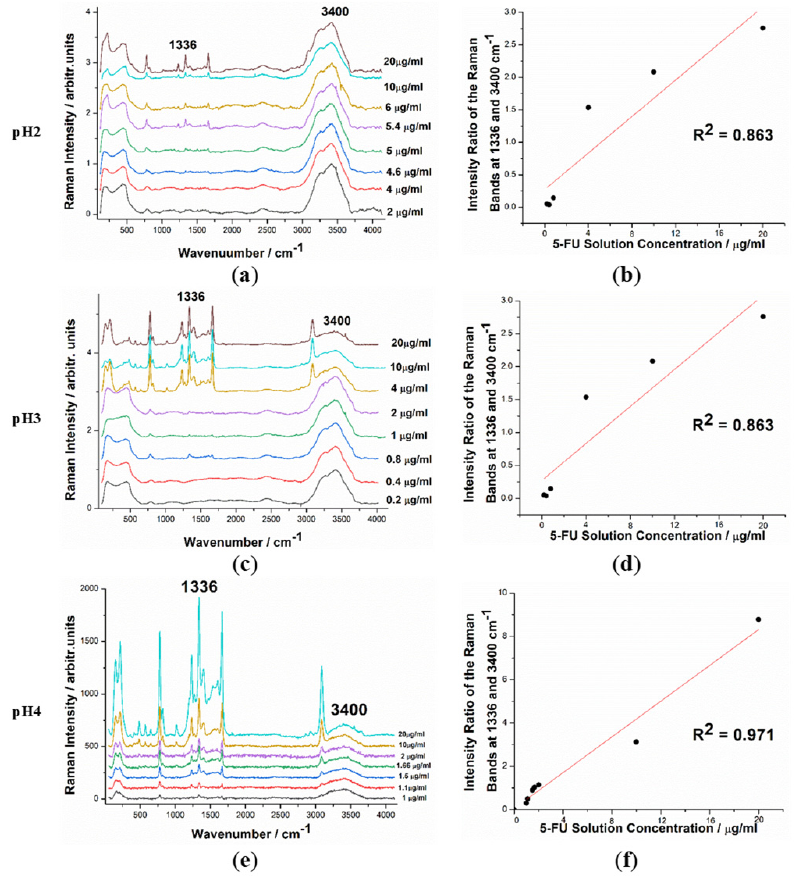
Figure 3. Normalized SERS spectra of 5-FU at concentrations ranging from 0.2 to 20 µ g/mL, with the main SERS bands tagged for pH 2 ( a ), pH 3 ( c ), and pH 4 ( e ). Intensity ratio of the 5-FU band at 1336 cm − 1 and the water band at 3400 cm − 1 plot against the concentration for pH 2 ( b ), pH 3 ( d ), and pH 4 ( f ).